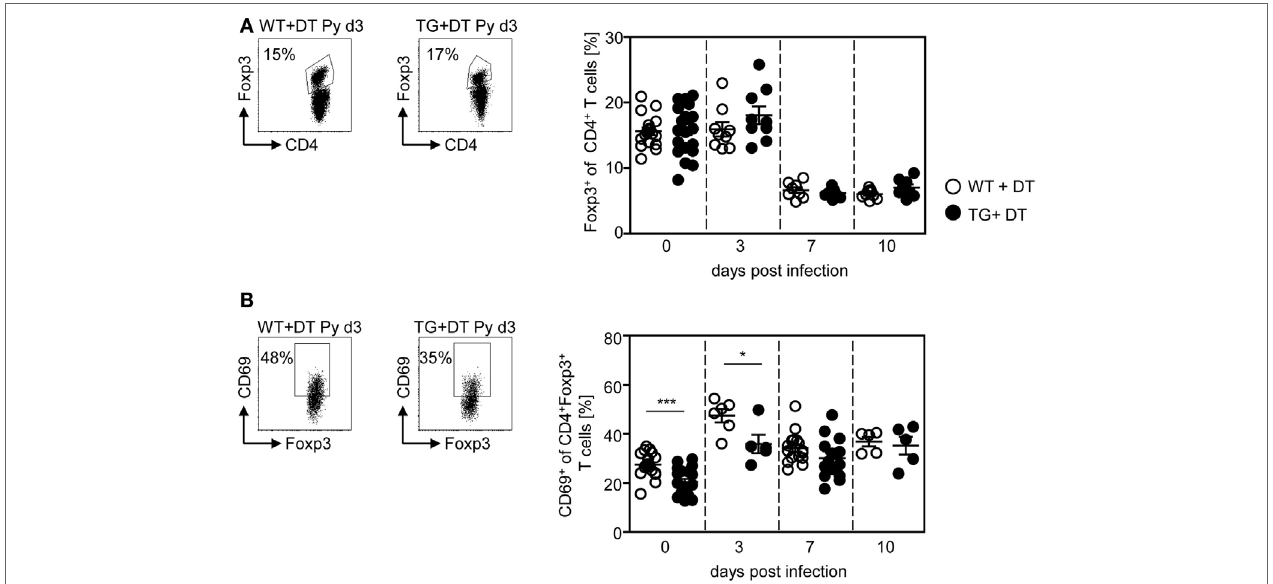
FigUre 4 | Long-term depletion of CD11c high dendritic cells interferes with activation of Foxp3 + regulatory T cells (Tregs) during Plasmodium yoelii infection. RosaiDTR/CD11c-cre (TG) and RosaiDTR wild-type (WT) mice were injected daily with DT ( + DT) and infected with P. yoelii 1 day later. Splenocytes were isolated at indicated time points and the percentages of (a) CD4 + Foxp3 + Tregs as well as (B) CD69-expressing CD4 + Foxp3 + Tregs were analyzed by flow cytometry. Representative dot plots are shown in the upper panels. Results from two to five independent experiments with n = 8–16 mice per time point (d0; n = 18–21 mice) were summarized as mean ± SEM. Each data point represents one animal. Statistical analysis was performed as described in the material and methods section with * p < 0.05; *** p < 0.001.